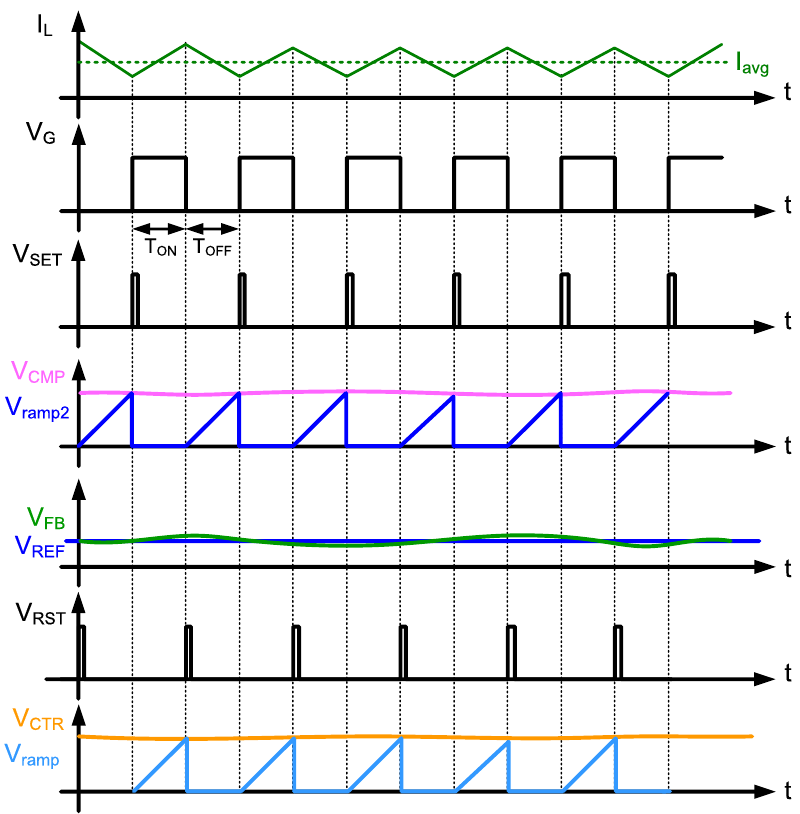
Figure 6. Key waveforms of Figure 5.